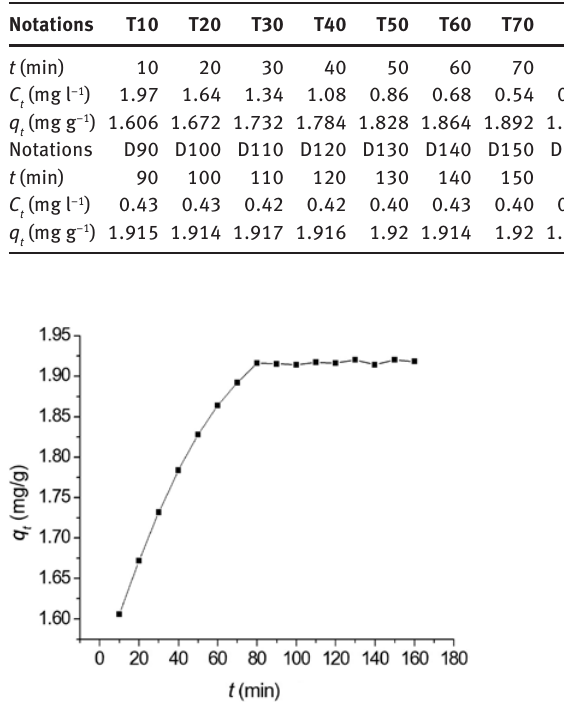
Figure 10: Pseudo-first-order model (A) and pseudo-second-order model (B) for fluoride adsorption. Figure 9: The relation bewteen q